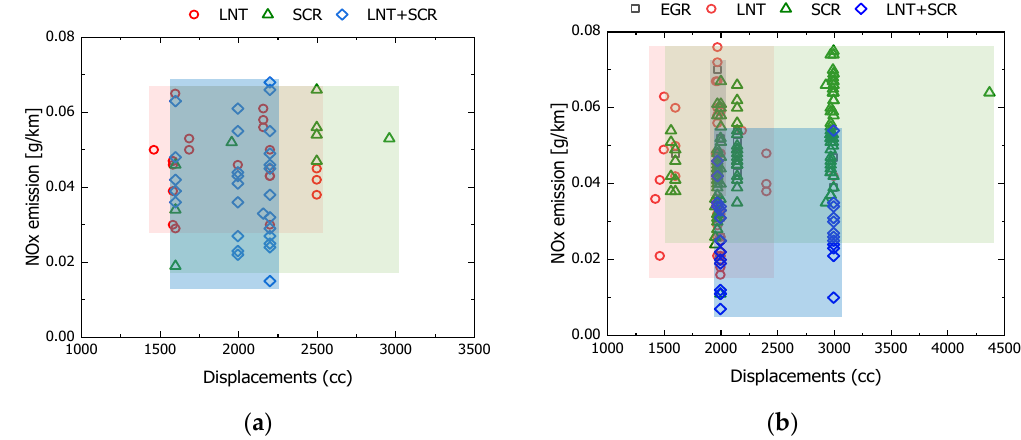
Figure 8. NO x emission characteristics according to after-treatment system and power for the domestic and imported vehicles in Korea. ( a ) Domestic vehicles; ( b ) Imported vehicles.